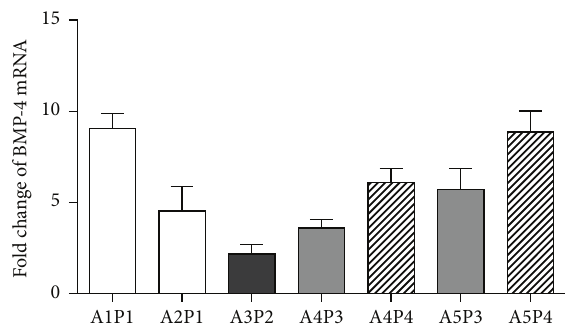
Figure 7: Consistent changes in BMP-4 expression in various ASCs lines in response to tPR. Changes in BMP-4 expression were relatively consistent across various ASC lines (A1–A5) exposed to different tPR preps (P1–P4). A similar pattern was seen with the other genes examined in this study. While certain PR preps, P4 in particular, tended to increase BMP-4 expression to a greater extent than others (P3), all preps increased